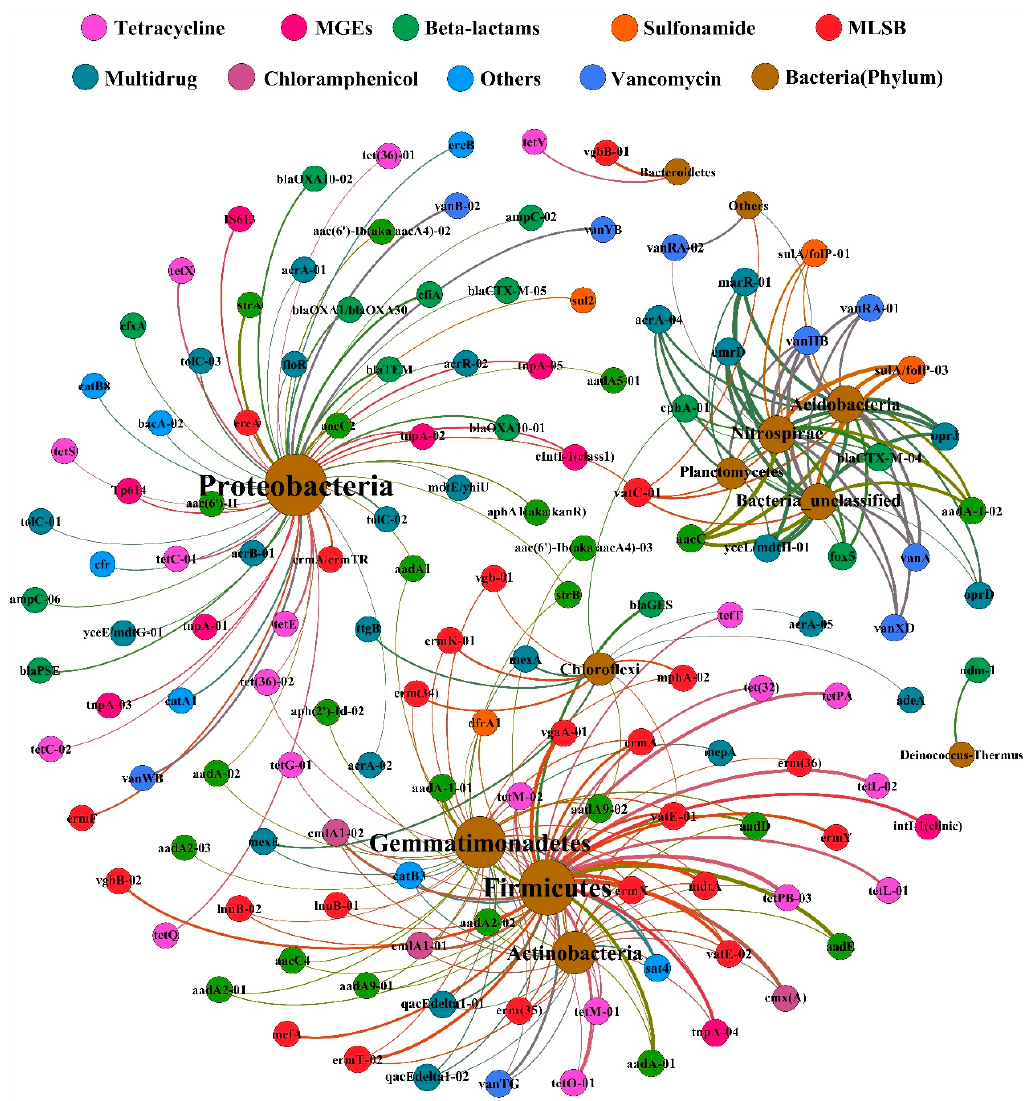
Figure 9. Network analysis of cooccurrence between ARGs, MGEs, and bacteria. Relationships between ARGs, MGEs (relative gene copy number), and bacteria (at the phylum level, 16S rRNA gene sequence data) based on Pearson’s correlation coefficients ( p < 0.05). The nodes are colored according to ARG class and phylum, and the node size is dependent on the number of connections to other nodes (degree). Each connection represents a significant correlation ( p < 0.05), and the edge line width represents the corresponding Spearman’s correlation coefficient.